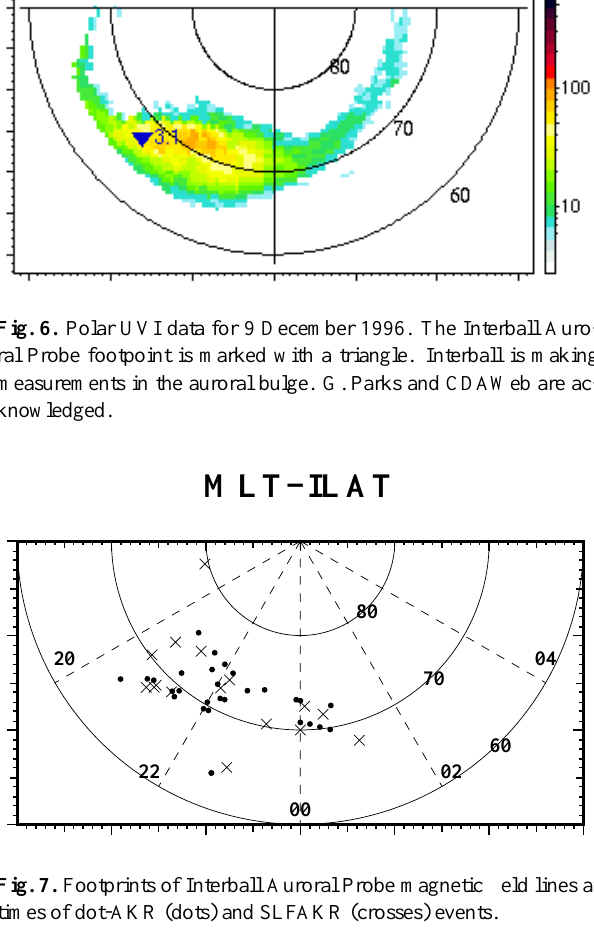
Fig. 7. Footprints of Interball Auroral Probe magnetic field lines at times of dot-AKR (dots) and SLFAKR (crosses)